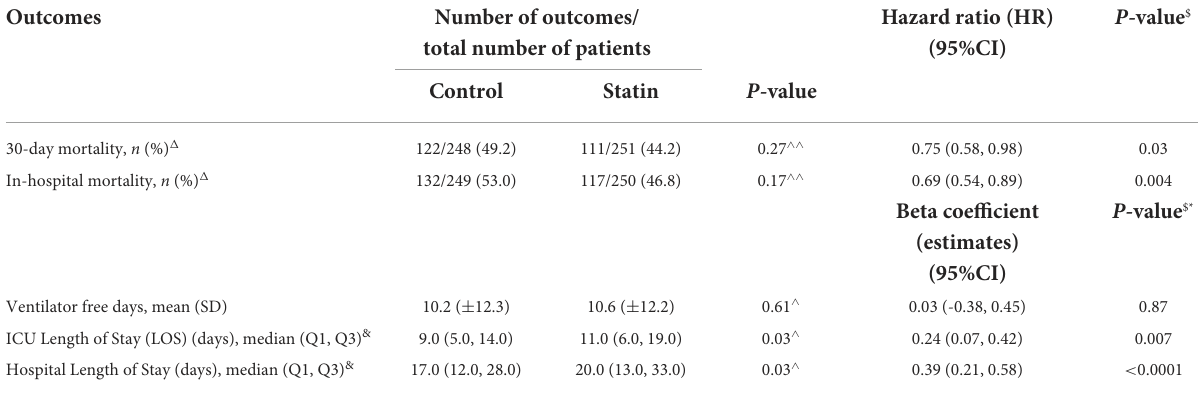
TABLE 2 The outcomes of critically ill patients with COVID-19 after propensity score matching.